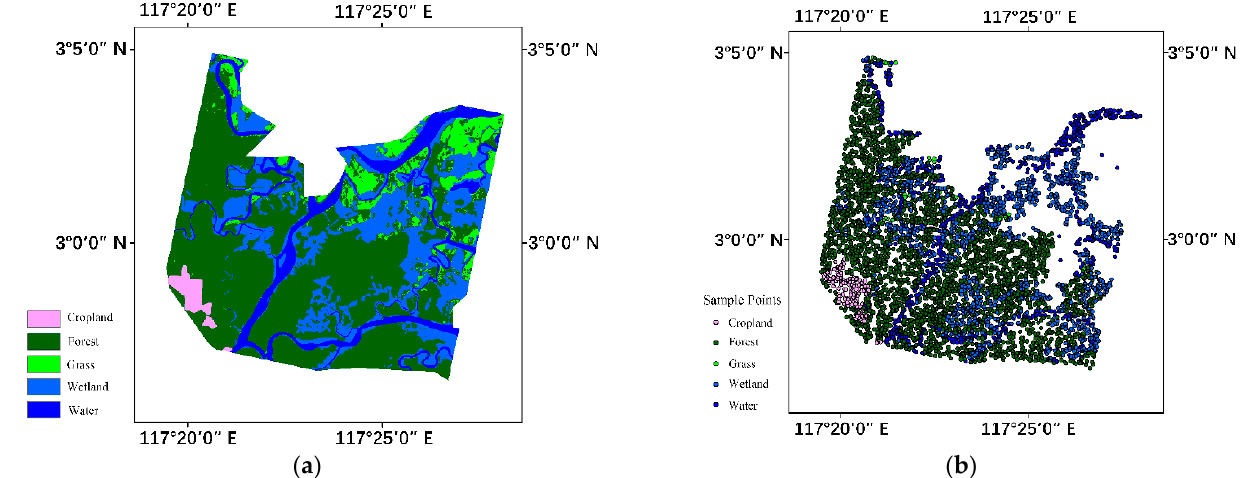
Figure 3. Demonstration area of ( a ) Globeland30-2015 and ( b ) interpreted sample points distribution map.